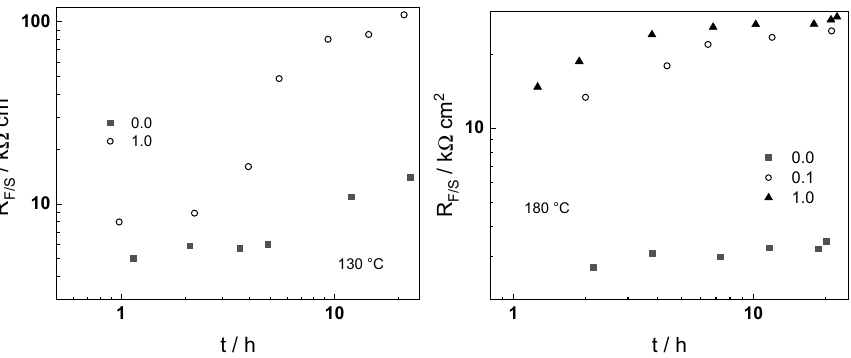
Figure 8. Time dependences of the charge transfer resistance at the protective film/coolant interface at 130 ( left ) и 180 ° С ( right ) without and with 0.1 and 1.0 g dm − 3 Fe 3 O 4 addition.